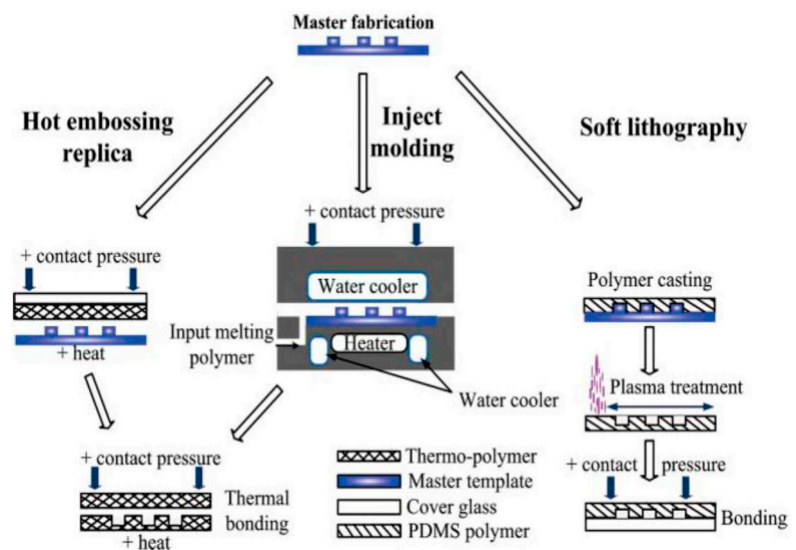
Figure 2. Representation of the fundamental molding methods for microfluidics fabrication. Reprinted from an open-access source [54]. PDMS: polydimethylsiloxane.